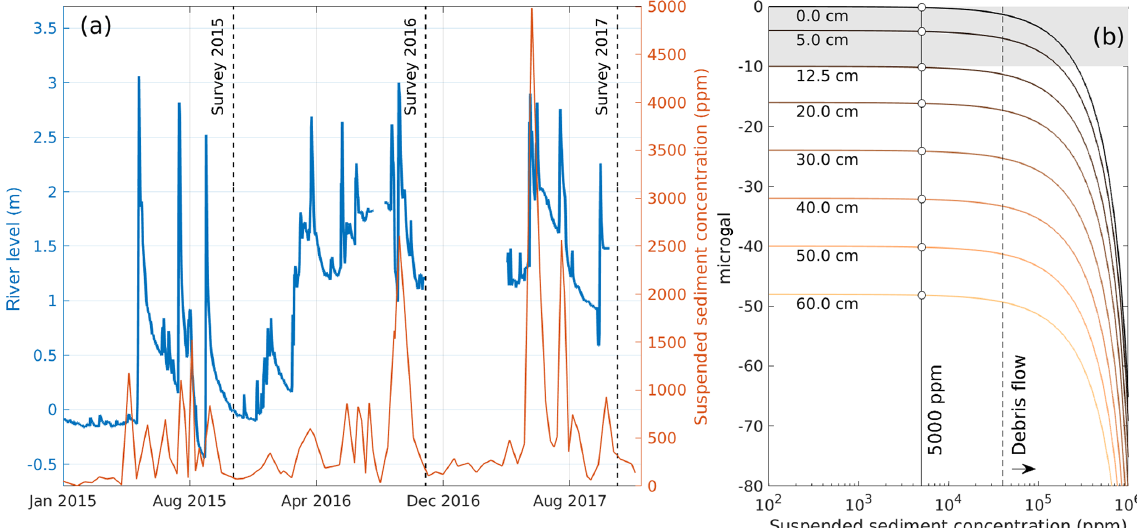
Figure 12. (a) River level and sediment concentration of Laonong River, measured at Liugui station about 20km downstream from Paolai. The highest sediment concentration (5000ppm) was reached in summer 2017, when the river level increased by about 1.6m. Data are freely available from the Taiwan WRA (Taiwan Water Resources Agency, 2019). (b) Estimated gravity changes at the buried network (Fig. 11c) as a function of the variations of the suspended sediment load and of increasing amounts of bed-load-transported sediment. The bed load fraction is considered here a homogenous layer of 0 to 60cm thickness (labeled on each curve) and density 2 × 10 3 kgm − 3 . The river becomes a debris flow when its suspended sediment concentration goes beyond 4 × 10 4 ppm. The 5000ppm level is shown as a reference. Note that the gravity sign is negative because the mass is increased above the